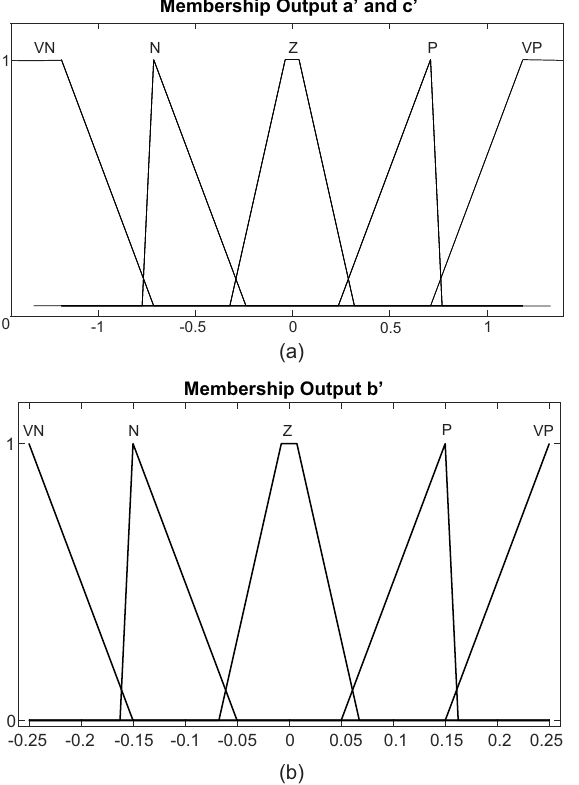
Figure 5. Outputs of 5 × 5 MFs designed in MATLAB/SIMULINK. ( a ) Variables a and c, and ( b ) variable